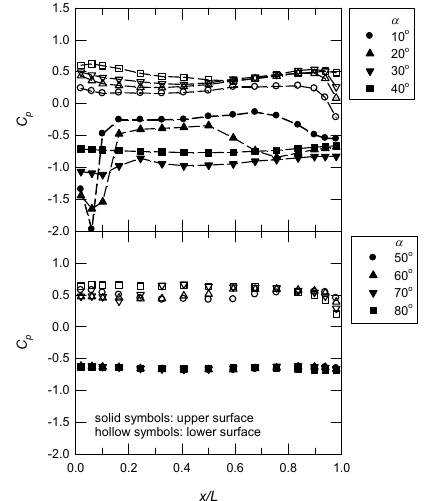
◦ . Appl. Sci. 2019 , 9 , x FOR PEER REVIEW